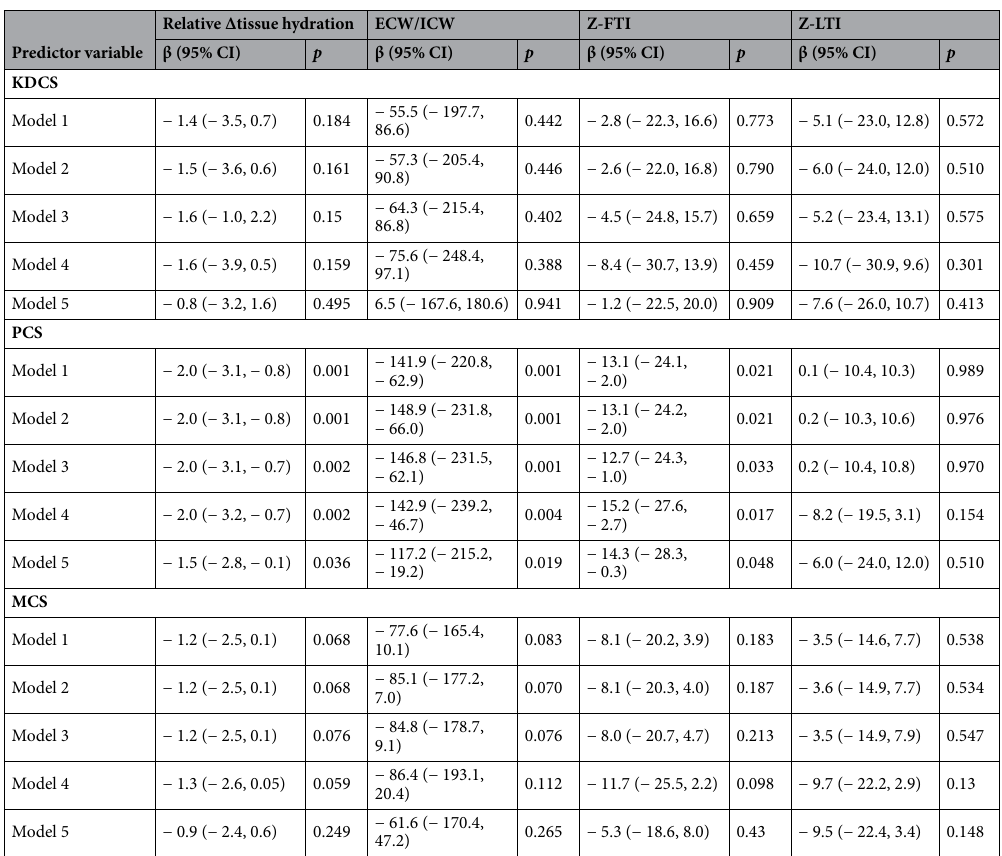
Table 4. Regression coefficients of the body composition parameters for HRQOL scores. Model 1: Unadjusted. Model 2: Adjusted for age and sex. Model 3: Adjusted for Model 2 plus dialysis duration, Kt/V, total creatinine clearance, and C-reactive protein. Model 4: Adjusted for Model 3 plus relative ∆tissue hydration, Z-FTI, and Z-LTI. Model 5: Adjusted for Model 4 plus diabetes mellitus and usage of renin–angiotensin–aldosterone component summary, PCS physical component summary, MCS mental component